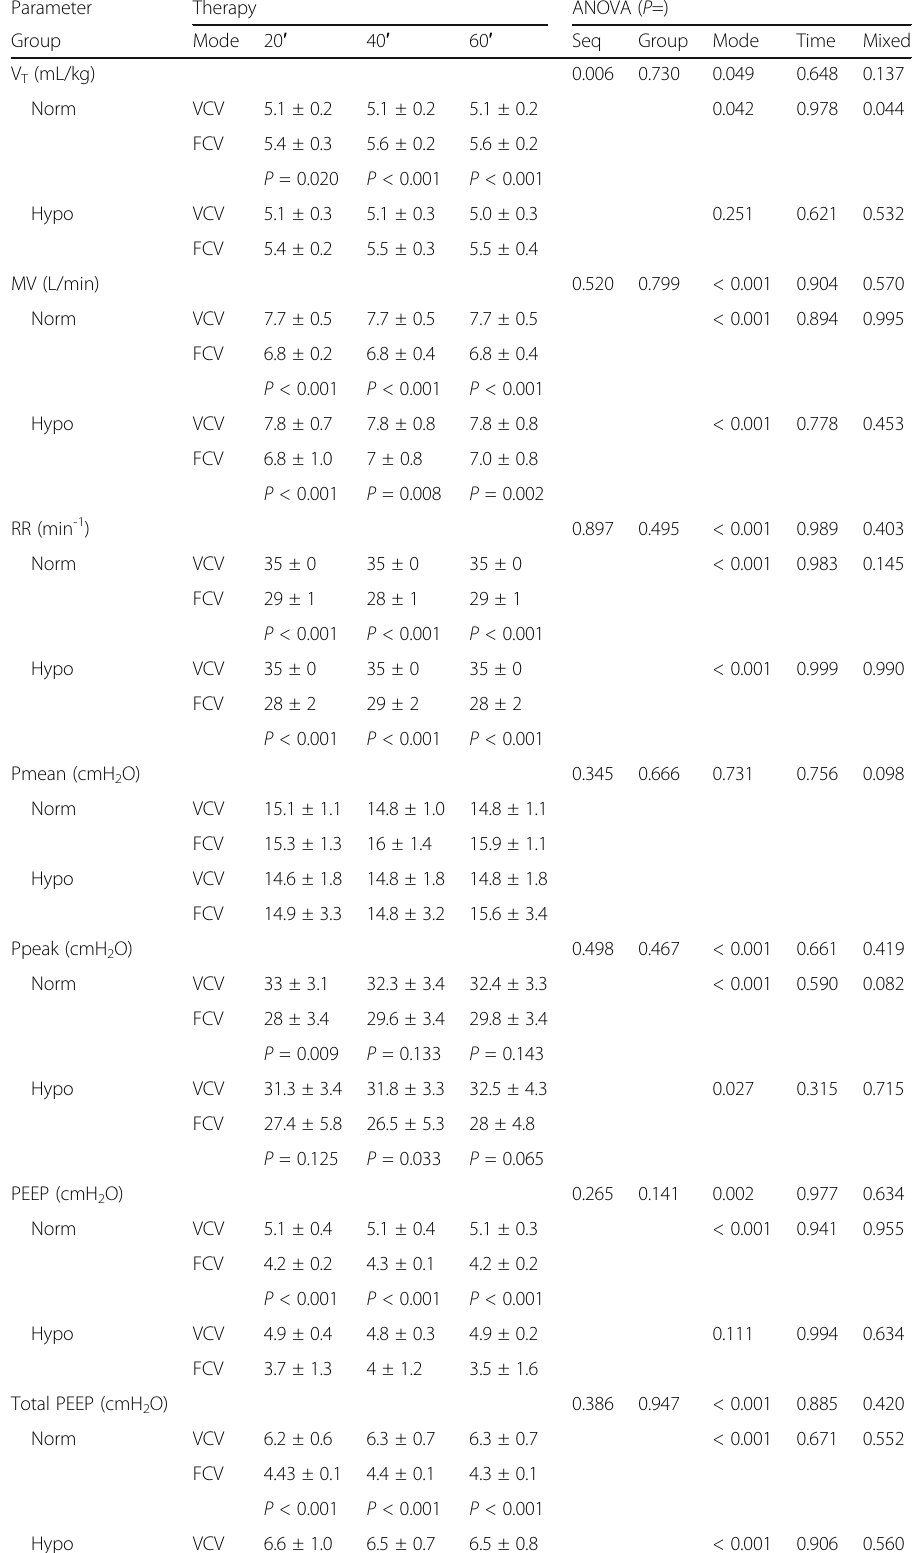
Table 2 Respiratory